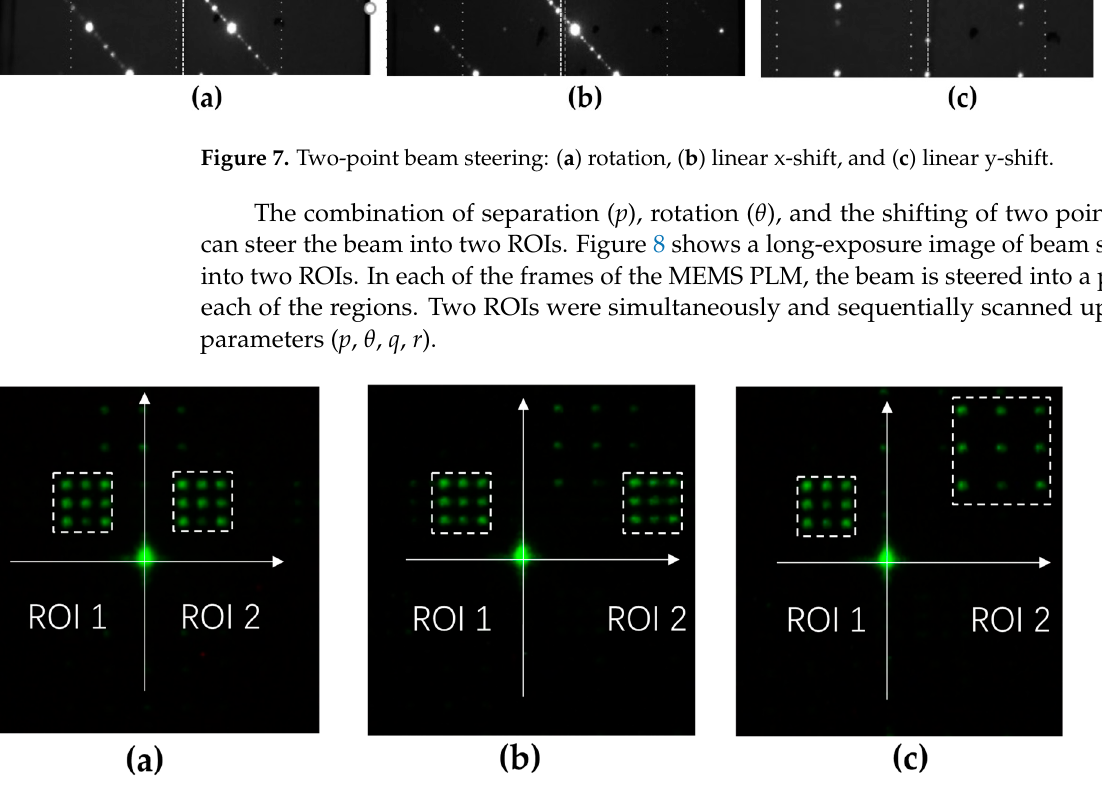
Figure 8. Two-point beam steering using binary gratings with ROIs of ( a ) symmetrical and equal area, ( b ) asymmetrical and equal area, and ( c ) asymmetrical and non-equal area.